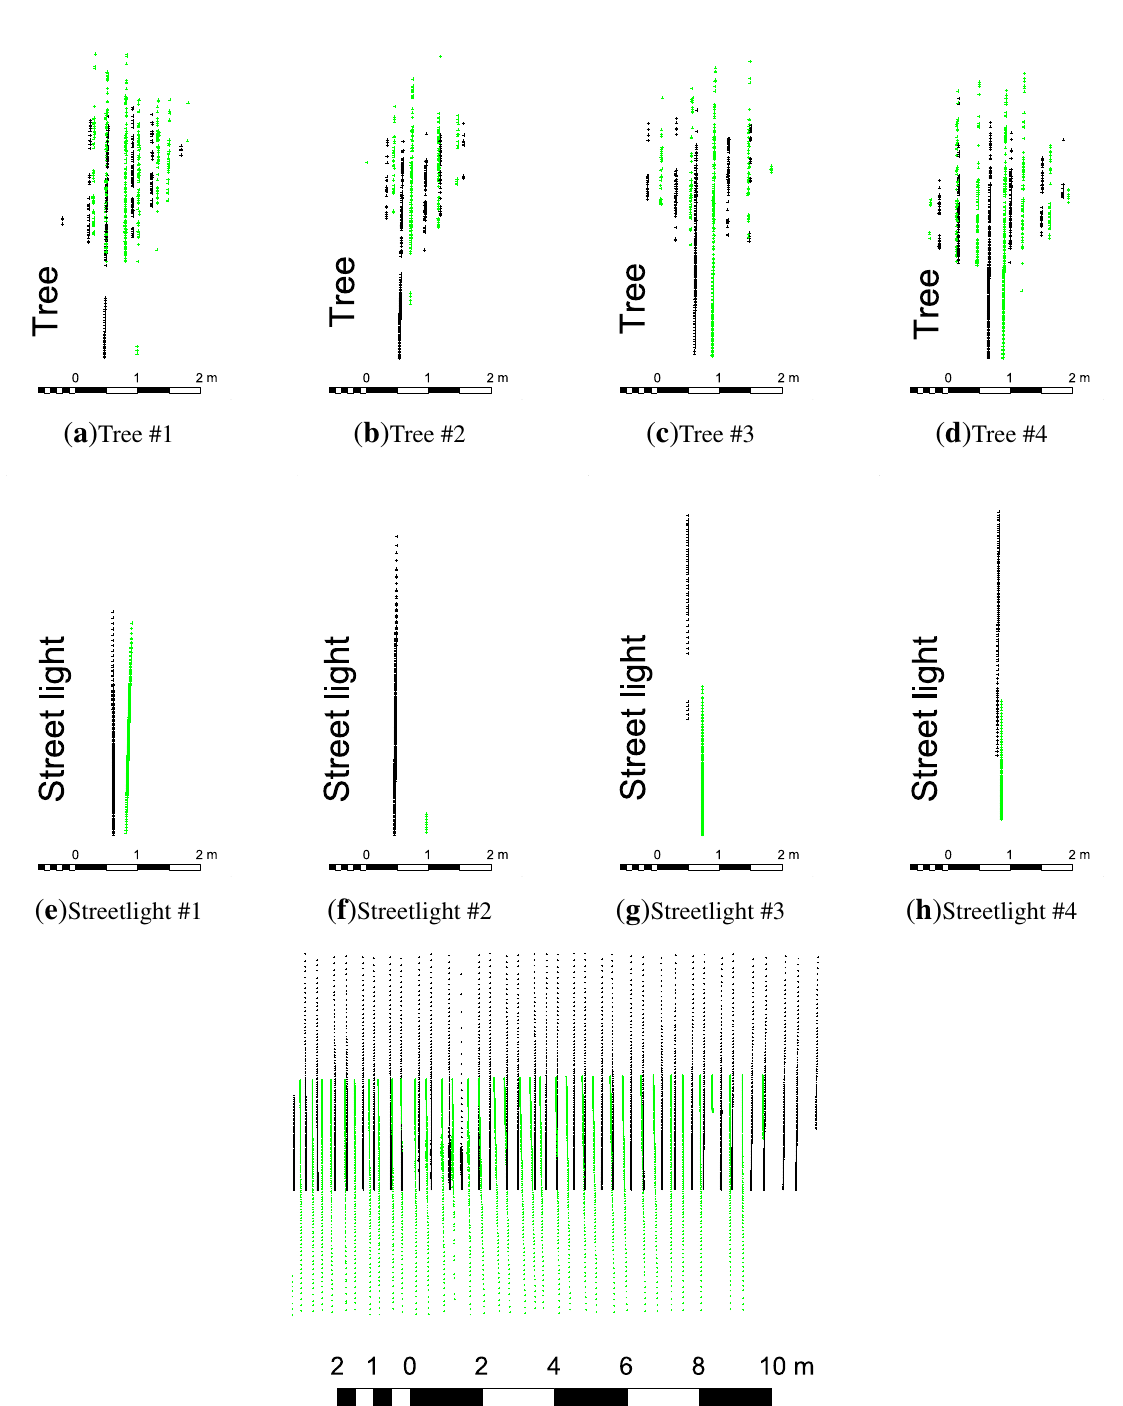
Figure 17. Tree and street light point clouds and distance between scans for the two paths. Graph scales are in meters. Black and green lines belong to forward and backward paths,